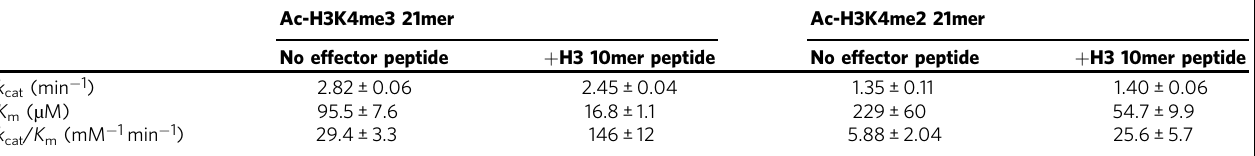
Table 2 Kinetic parameters of KDM5A 1-797 reacting with various substrates with and without effector